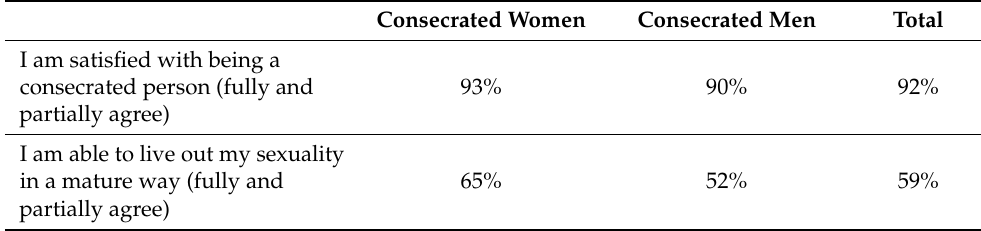
Table 3. Responds for the selected questions. N =